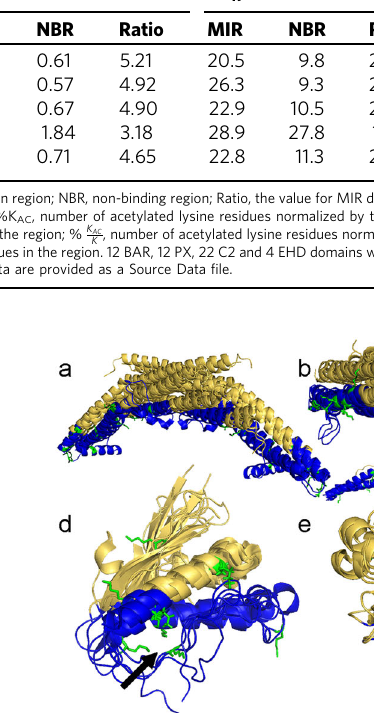
Fig. 2 Acetylation within domains is primarily localized to membrane-interaction regions. Overlays of all structures from a N-BAR, b F-BAR (top - central region, below - tip region), c PX-BAR, d PX (arrow indicates PI binding pocket), e C2 (arrow indicates Ca 2 + -independent binding region; arrowhead indicates Ca 2 + binding loops 1 – 3), and f EHD helical domains (arrow indicates membrane-interacting tip region of the α 9 helical domain as de fi ned for EHD2). For a detailed list of PDB structures, see supplementary excel and Supplemental Figs. 2 – 5. MIRs are shown as ribbons in blue. NBRs are shown as ribbons in gold. Acetylated lysines are shown as sticks in